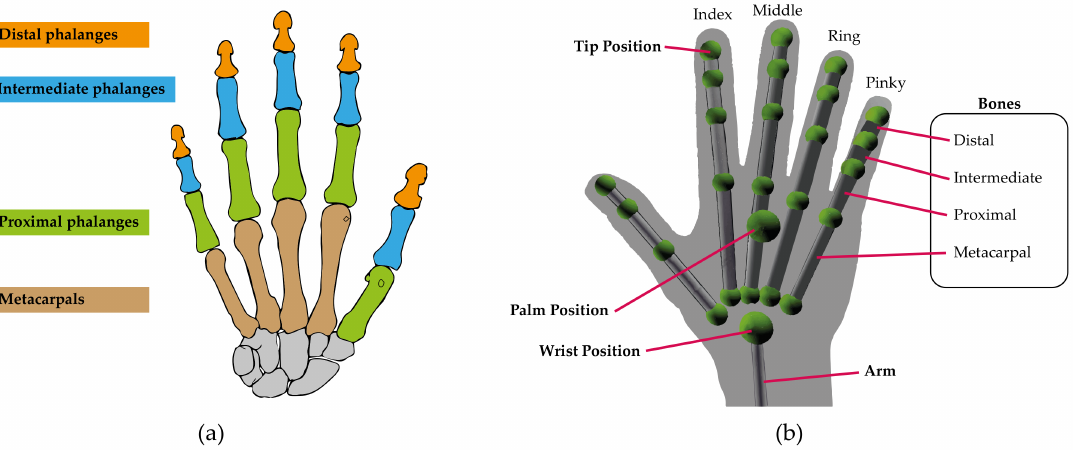
Figure 4. Tracking of the hands skeletal model ( a ) Object Bone. Source available online: https:// developer-archive.leapmotion.com/documentation/javascript/devguide/Leap_Overview.html (ac- cessed on 29 December 2022) ( b ) Object Hand. Source available online: https://ieeexplore.ieee.org/